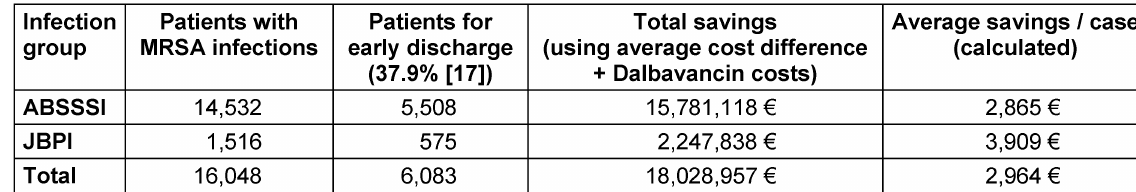
Table 5: Summary of the savings calculation using the proportion of dischargeable patients as well as average cost difference between MRSA and non-MRSA infections adding Dalbavancin treatment